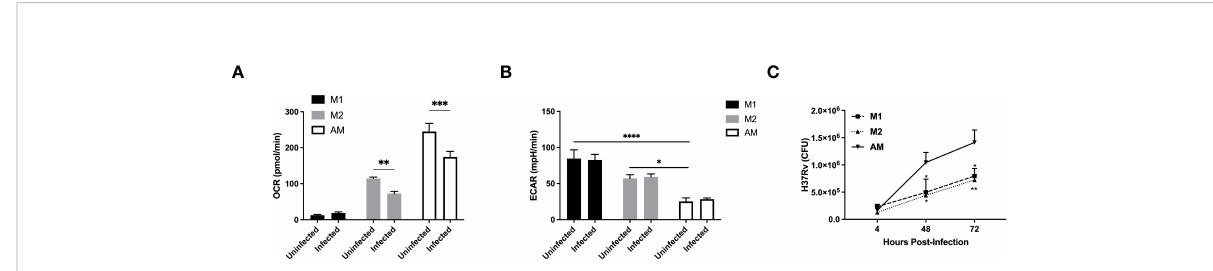
FIGURE 3 A virulent strain of Mtb inhibits the glycolytic pathway in both AM and BMDM M1/M2 bone marrow-derived and naïve alveolar macrophages were subjected to a Seahorse assay to measure cellular metabolism before and after 24hrs of infection with H37Rv at MOI of 1. (A, B) Quanti fi cation of basal OCR (A) and ECAR (B) in macrophages infected with H37Rv. (C) M1 and M2 bone marrow-derived and naïve alveolar macrophages were infected at MOI 1 with H37Rv and subjected to CFU assays. Data are given as mean ± SEM. The data are representative of 4 (A, B) or 3 (C) independent experiments. *p<0.05; **p<0.01; ***p<0.001, ****p<0.0001 determined by 2-way ANOVA followed by Tukey ’ s or Sidak ’ s multiple